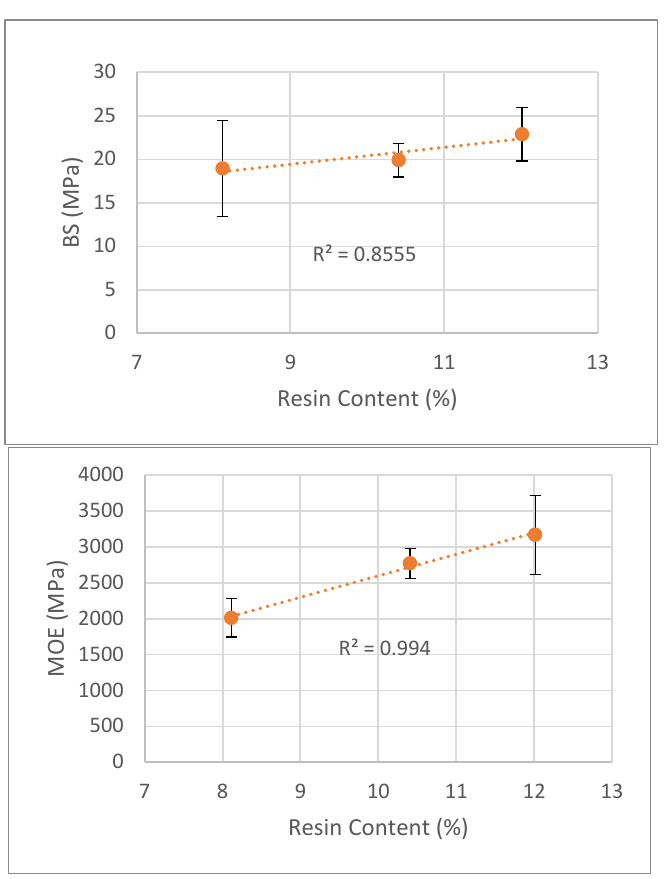
Figure 6. Correlation between bending strength and MOE variation and resin content.